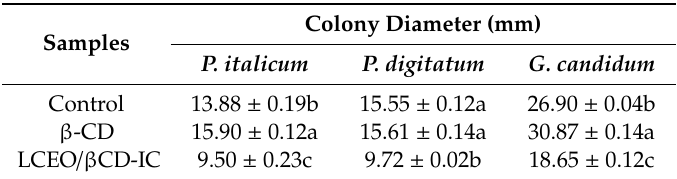
Table 5. The colony diameter of tested fungi in potato dextrose agar (PDA) medium containing β -CD and LCEO / β